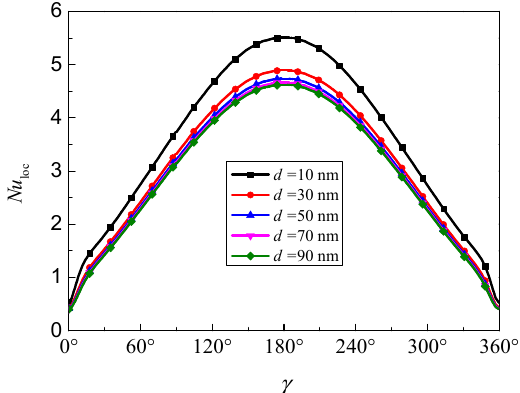
Figure 12. Average Nusselt number ( Nu loc ) of the inner wall for different nanoparticle diameters ( d sp ) and Darcy numbers ( Da ) at Ra = 5 × 10 4 , ϕ = 0.05, ε = 0.5, and RR = 2.